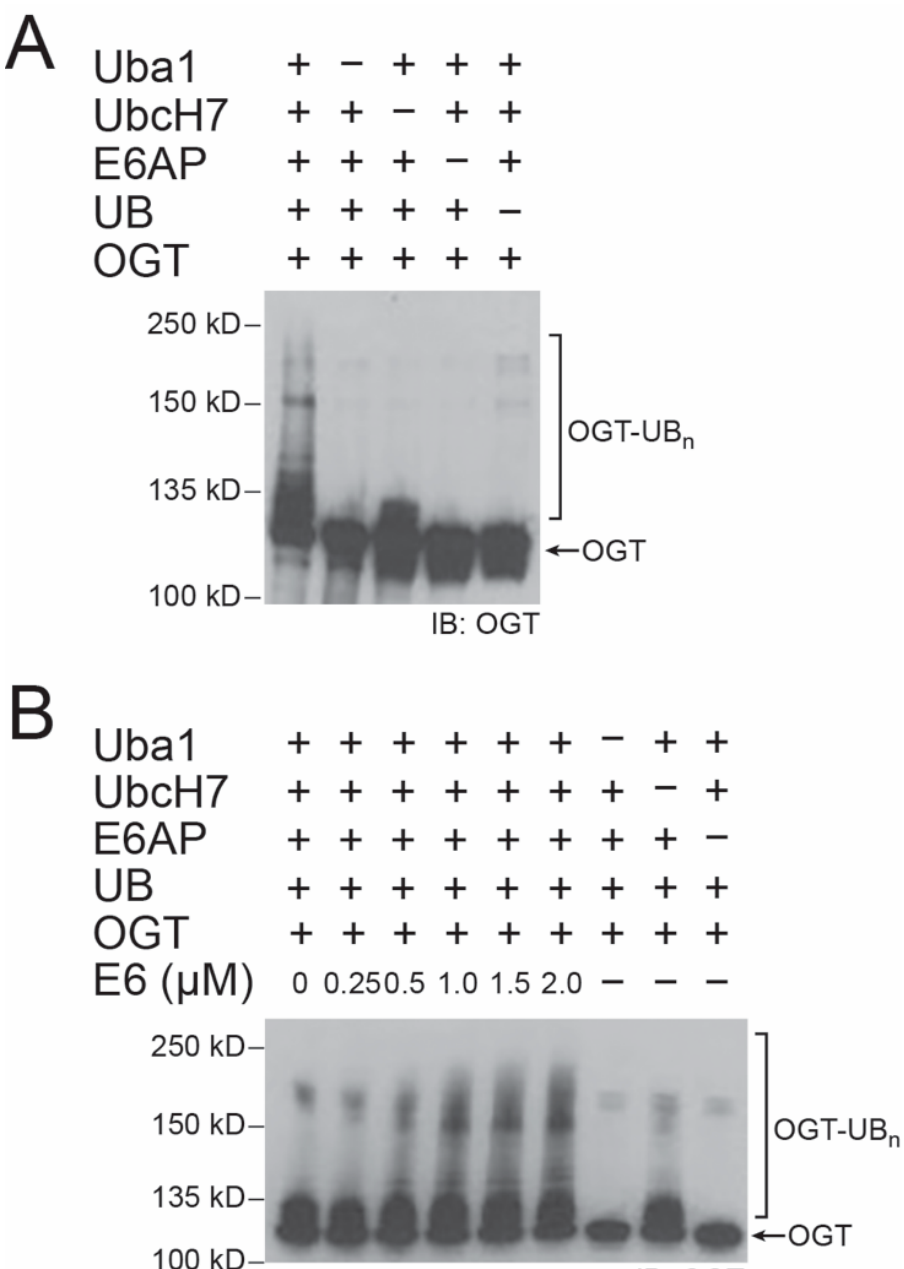
Figure 1. E6-mediated stimulation of OGT ubiquitination catalyzed by E6AP. ( A ) E6AP catalyzed OGT ubiquitination in reconstituted reactions in vitro. Control reactions were set up with Uba1, UbcH7, E6AP, or UB excluded from the reaction. Western blot of the reaction mixture was probed with an anti-OGT antibody. ( B ) HPV E6 enhanced the activity of E6AP in OGT ubiquitination. The ubiquitination reaction was set up with an increasing concentration of E6 in the range of 0–2 µ M, and the level of OGT ubiquitination was probed with an anti-OGT antibody. The Western blot shown in ( B ) was exposed for a shorter time than that in ( A ) to reveal the difference of OGT ubiquitination in reactions with E6